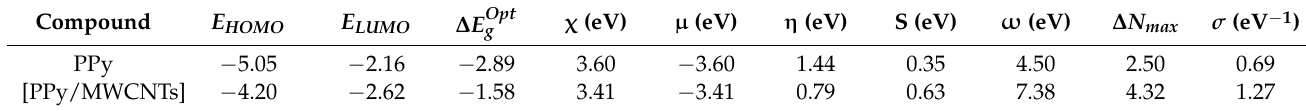
Table 3. Geometry constant for PPy/MWCNTs composites gas